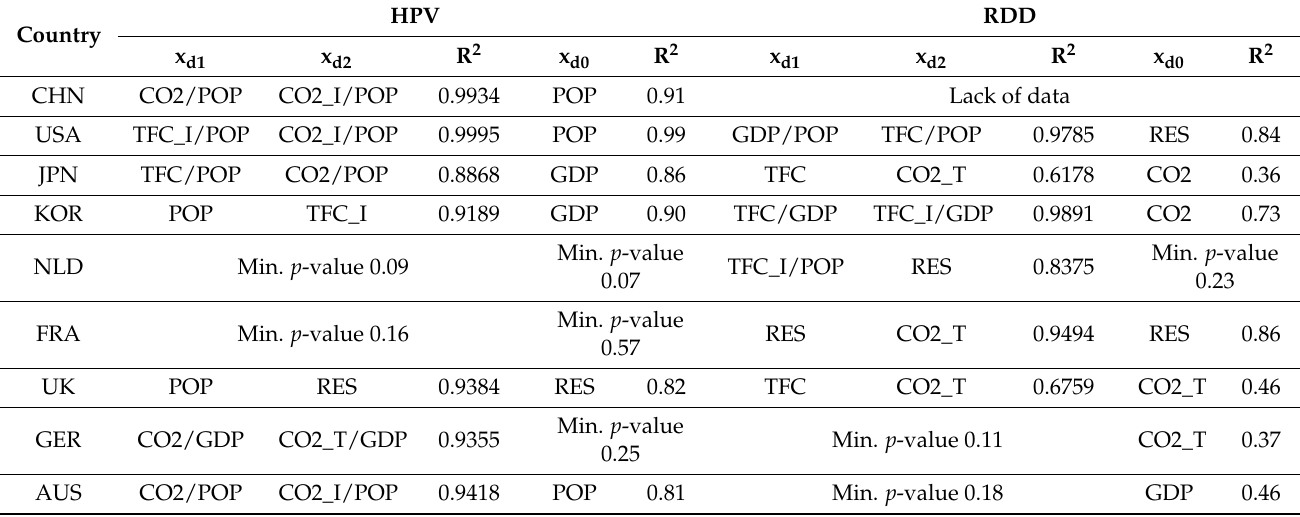
Table 4. Selected parameters x d0 , x d1 , and x d2 for which R 2 is the highest under the condition p -value < 0.05. Country